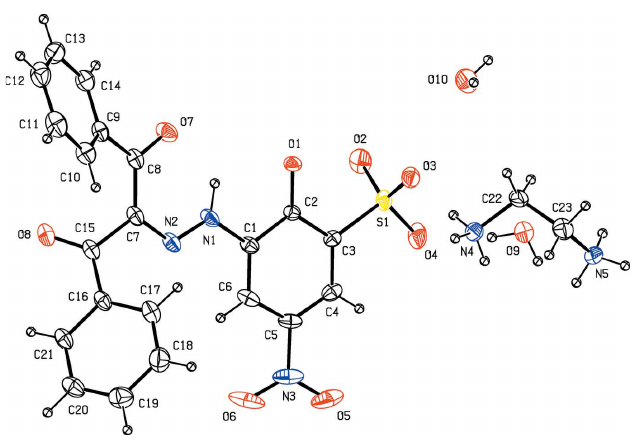
Figure 1 The molecular structure of the title compound. Displacement ellipsoids are drawn at the 30% probability level. H atoms are shown as spheres of arbitrary radius.